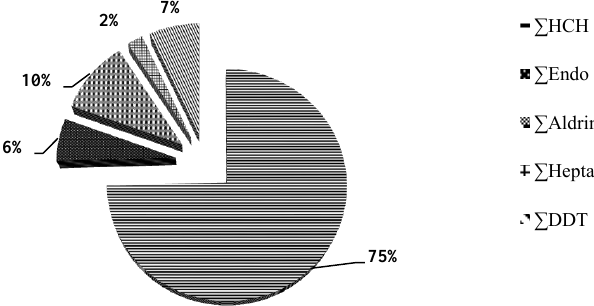
Figure 4. Detection frequency of individual OCPs across UK stretch of Ganga Figure 4: Detection frequency of individual OCPs across UK stretch of Ganga River